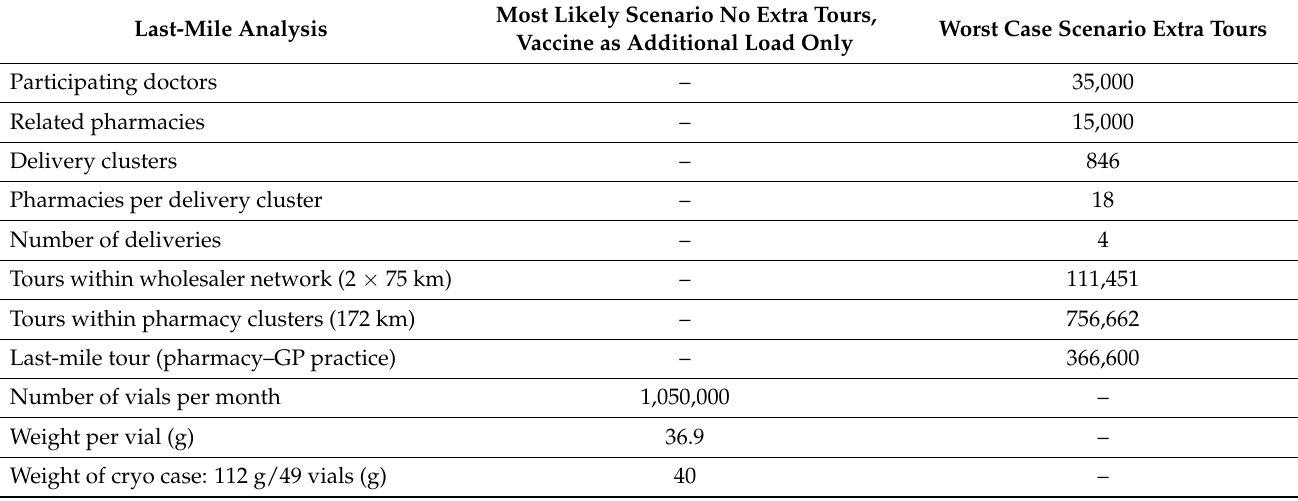
Table 4. Distribution of 1 million vials for a demand of 6,300,000 doses in the course of 1